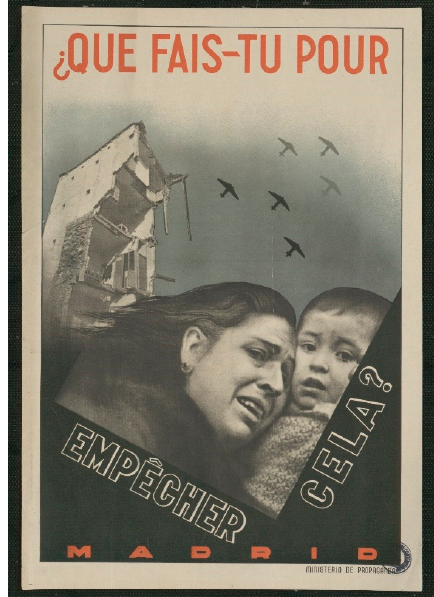
Figure 17. Peter Alama. “What Are You Doing to Stop This?” Photograph, ink on paper. La Figure 17. PeterAlama. “WhatAreYouDoingtoStopThis?”Photograph, inkonpaper. LaContemporaine. Contemporaine. AFF24125 (36). AFF24125